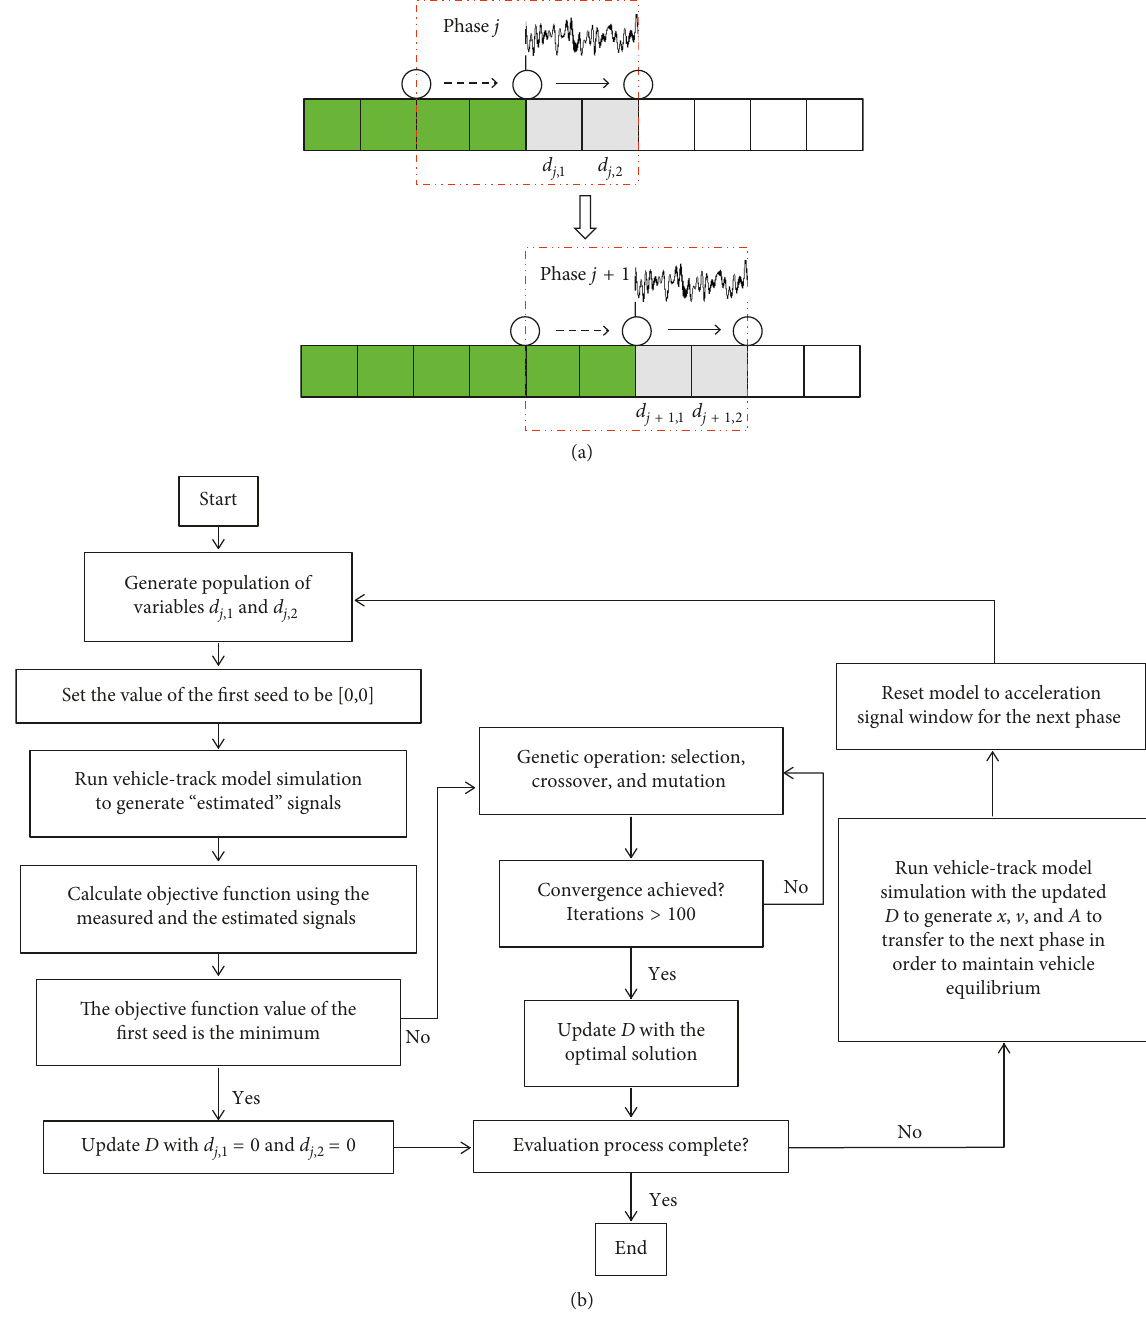
Figure 6: Improved genetic algorithm with a shifting window: (a) stepping procedure; (b) flowchart of CMDEA : Phase j